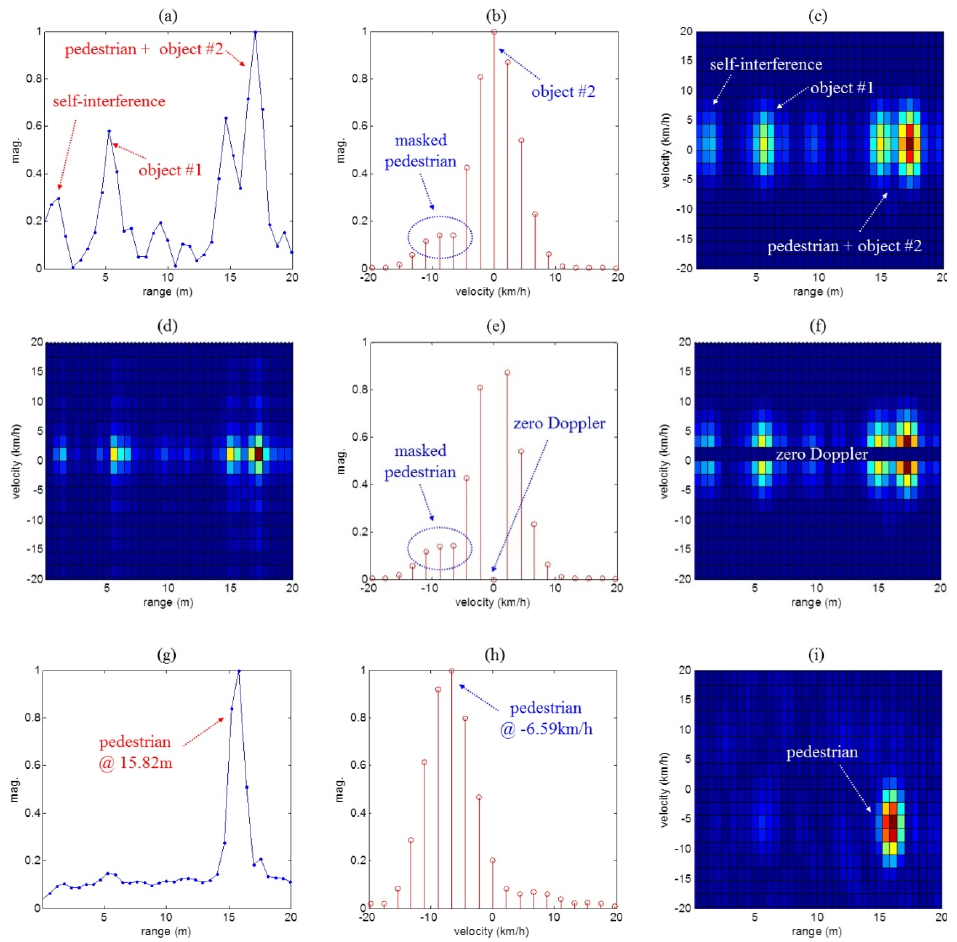
Figure 10. Measurement results using the conventional method and the proposed detection method for scenario (iii). Here, ( a – c ) present the results of typical method using windowing; ( d ) indicates the results of the typical method without windowing; ( e , f ) show the results of removing the zero Doppler components in the typical method; and ( g – i ) are the results of the proposed method.